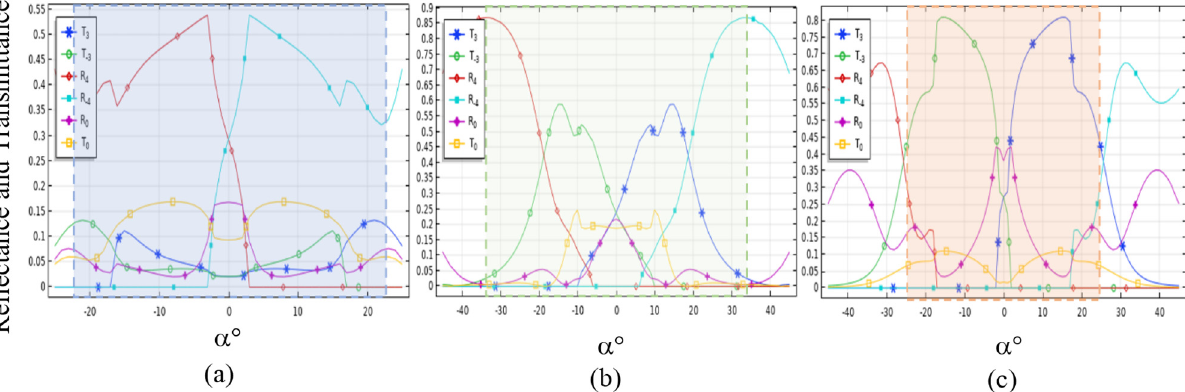
Fig. 5. Diffraction performance of the AlAs/Si metagrating for (a) blue, (b) green and (c) red light. The angular ranges in-coupled by the system are shaded. The angular ranges correspond to an incidence from the medium with refractive index n